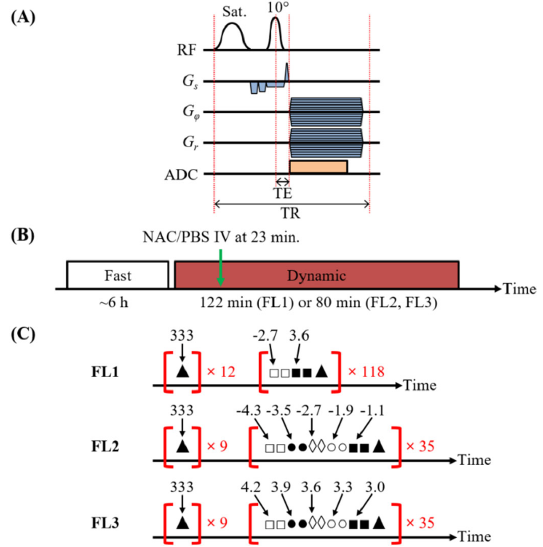
Figure 1. ( A ) The half ‐ echo acquisition mode CEST ‐ UTE pulse sequence [24]. After a 30 ms Gaussian saturation RF pulse, a crusher and pre ‐ spoil slice ‐ selective (G s ) gradient was applied, followed by a 1 ms slice ‐ selective Gaussian excitation pulse with a 10° flip angle. Subsequently, the phase ‐ encod ‐ ing (G φ ) and readout (G r ) gradients were switched on during the signal acquisition to acquire a single radial spoke in k ‐ space. ( B ) The experimental procedure used in this study. In the procedure, following a fasting period to reduce liver GSH levels, a dynamic scan was performed to monitor the hepatic NAC uptake and GSH increase as a function of time. The injection (green arrow) of NAC began at 23 min into the dynamic scan. ( C ) The three different frequency lists (FL1, FL2 and FL3) used for the dynamic scan experiments. For FL1, after the 12 dummy scans with the ω tx at 333 ppm, the ω tx was alternated between − 2.7 and 3.6 ppm. From the two iterations of the − 2.7 ppm images, only the signal intensity from the second image was used in the dynamic MTR curve; the same procedure was applied to the 3.6 ppm images. For FL2 and FL3, after the 9 dummy scans, the partial Z ‐ spectra were repeatedly acquired between − 4.3 and − 1.1 ppm (NAC thiol) or 4.2 and 3.0 ppm (GSH amide). Again, only the image from the second iteration of each frequency was used in the dynamic MTR curve. The interleaved 333 ppm scans were used to establish a S 0 baseline for the dynamic MTR curve data. 2.3. Preparation of Aqueous Liver Tissue Extracts for NMR Spectroscopy In the NMR analysis of the aqueous mouse liver extracts, a test group ( n = 6) and a control group ( n = 6) were used. The preparation of the extracts was performed according to the procedure reported by Beckonert et al. [25]. For the test group, the tail vein of each mouse was cannulated with a hand ‐ made catheter containing 90 μ L saline solution con ‐ nected to a syringe containing 50 g L − 1 NAC in PBS (pH 7) buffer. A 240 μ L bolus contain ‐ ing the 90 μ L saline solution in the catheter tube followed by 150 μ L of 50 g L − 1 NAC solution from the syringe was injected intravenously over 1 min using an automated sy ‐ ringe pump (Harvard Apparatus, Holliston, MA, USA). Each mouse was sacrificed at ap ‐ proximately eight minutes after starting the IV injection, and a piece of the liver was im ‐ mediately removed and placed in a 2 mL Eppendorf tube, weighed and then submerged in liquid N 2 . The frozen tissue was initially homogenised with 4 mL CH 3 OH and 0.85 mL H 2 O per gram of tissue, then vortexed with 2 mL g − 1 CHCl 3 . After the addition of another 2 mL g − 1 CHCl 3 and 2 mL g − 1 H 2 O, the tissue sample was vortexed again and then place in an ice ‐ bath for 15 min. The sample was then centrifuged (1000× g ) at 4 °C for 15 min or until the aqueous CH 3 OH/H 2 O phase was separated from the hydrophilic CHCl 3 phase. The aqueous phase was transferred into a glass vial for solvent removal via a speed vac ‐ uum concentrator. Afterwards, the solid aqueous extracts were resuspended using 0.58